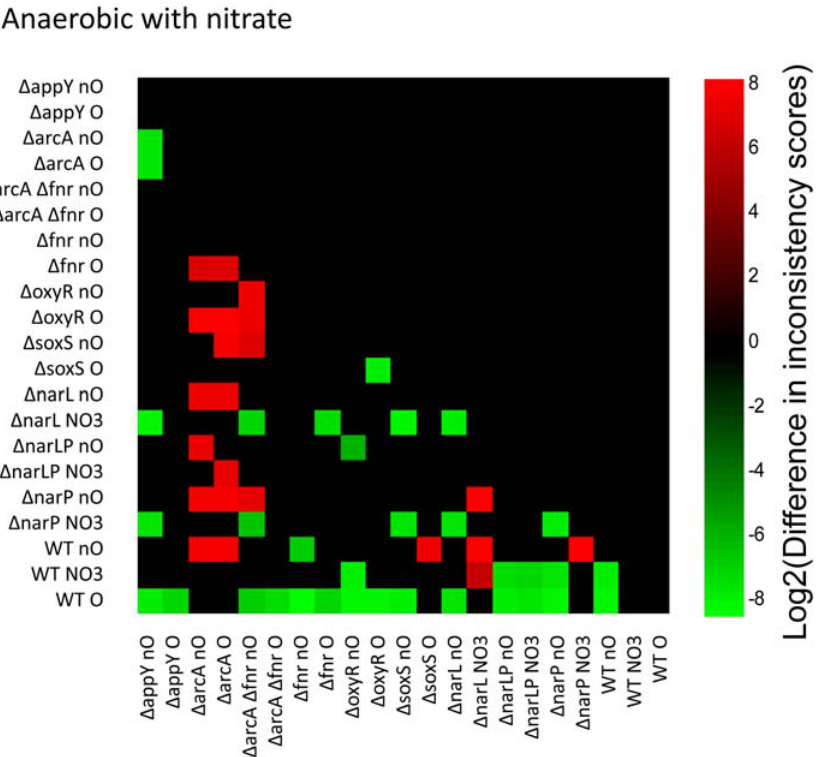
Figure 8. Pairwise comparisons of consistency for nitrate conditions. A graphical representation of the log2 transform of the difference between inconsistency scores. A green box indicates that the sample on the y -axis is more consistent with nitrate growth than the sample on the x - axis. Red boxes indicate the opposite. Differences that do not meet p , 0.05 are left blank. The shade of red or green quantifies the log2 of the difference in inconsistency scores. The position of green and red blocks indicates that in most cases, gene expression from strains grown with nitrate as the terminal electron acceptor is more consistent with efficient growth under this condition than strains grown under other conditions.